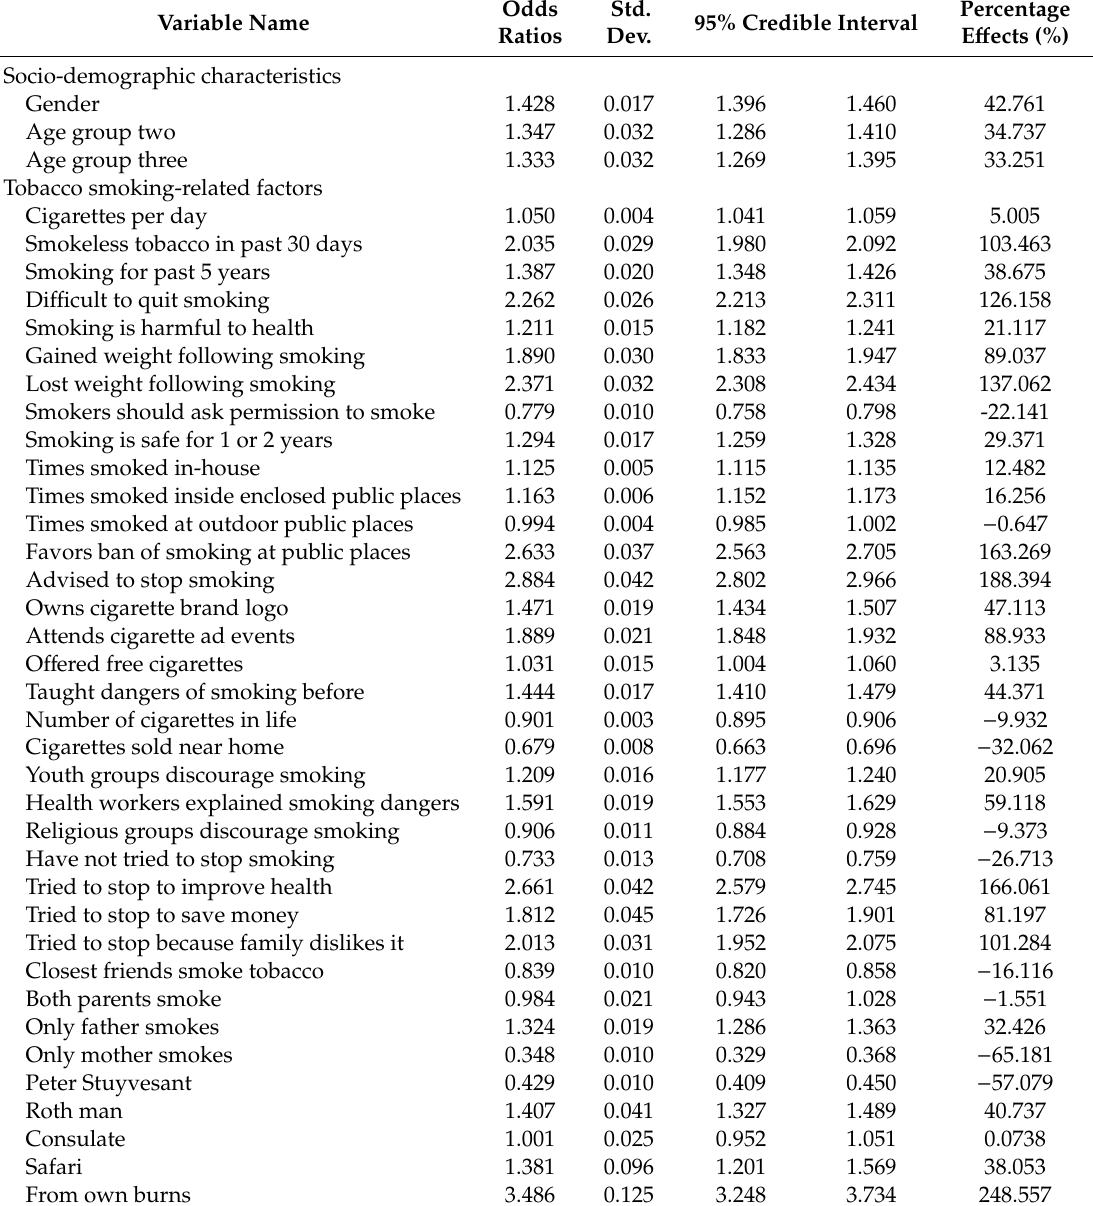
Table 3. Odds ratios, standard deviations, Bayesian 95% credible intervals, and percentage e ff